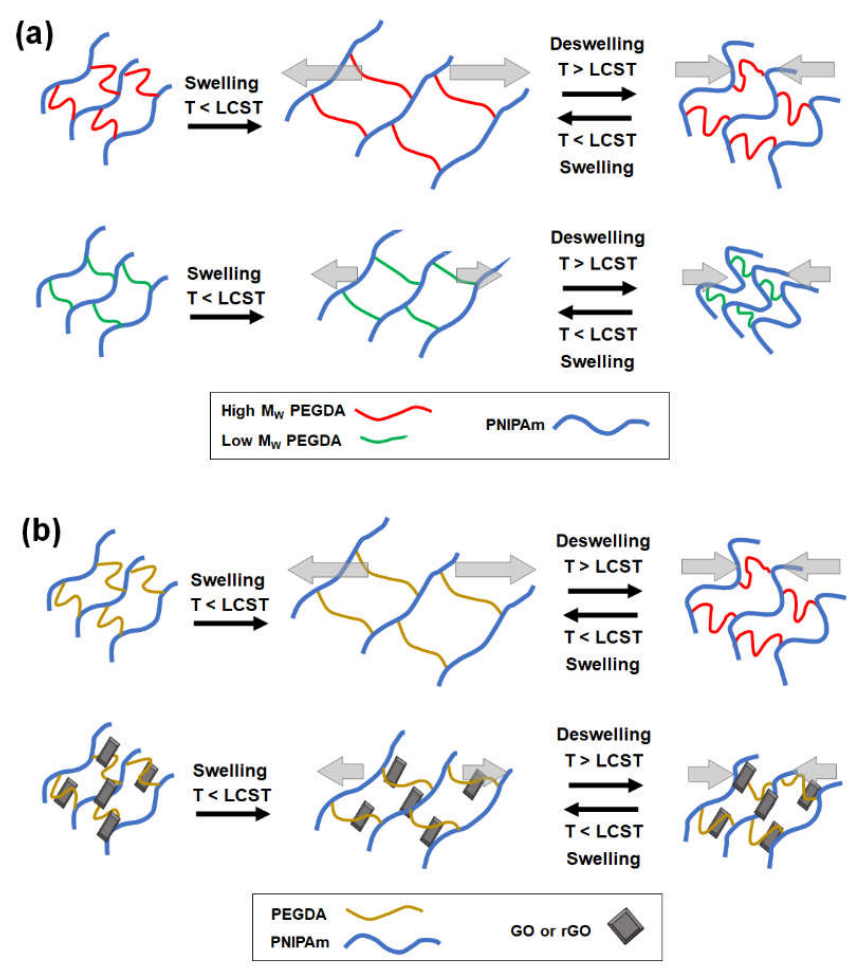
Figure 1. Schematic illustrations of controlling the thermoresponsive PNIPAm hydrogel actuators by ( a ) copolymerizing with PEGDA with varying M W and ( b ) forming nanocomposite with graphene (graphene oxide (GO) or reduced graphene oxide (rGO)). The hydrogels undergo the swelling/deswelling transition around a lower critical solution temperature (LCST).